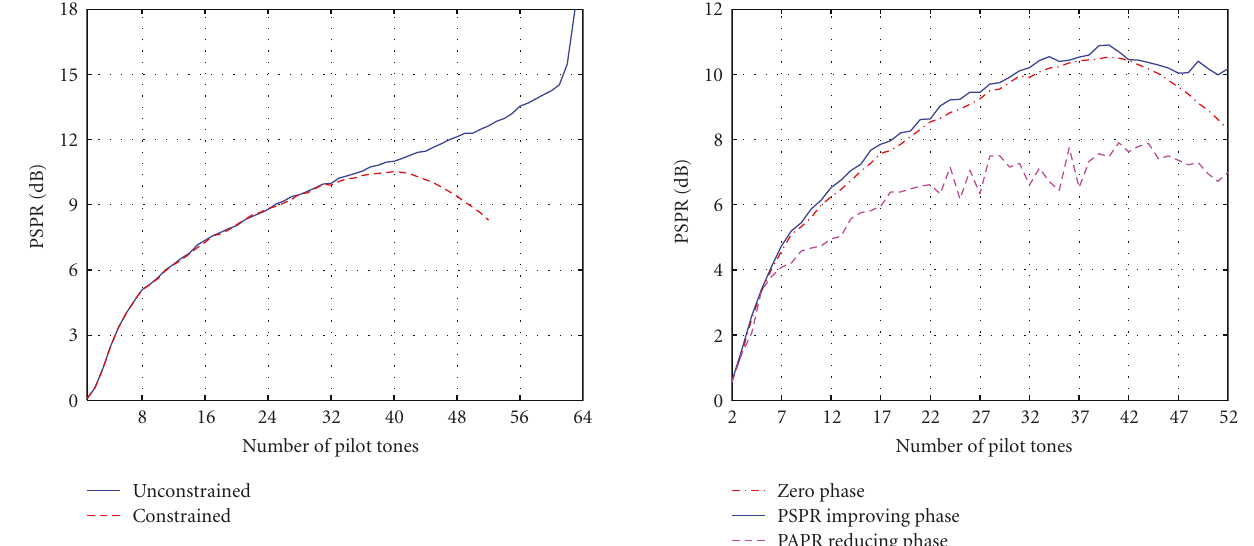
Figure 9: PSPR values of the synchronization waveforms. Note that the PSPR value does not increase monotonically with the number of pilot tones in the constrained case.